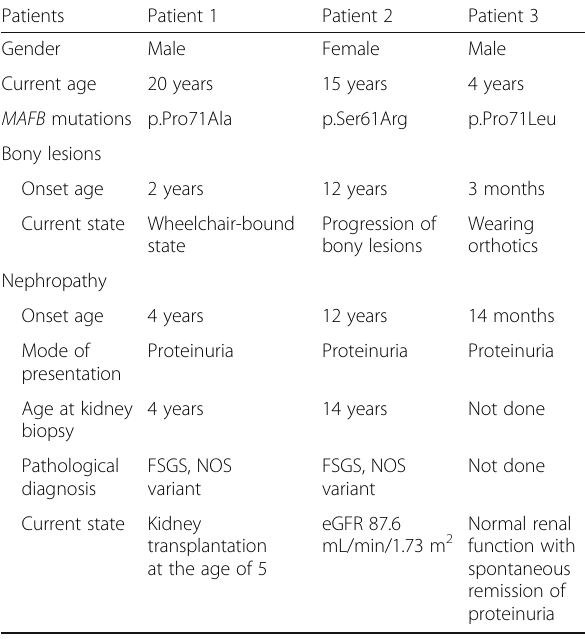
FSGS focal segmental glomerulosclerosis, NOS not-otherwise specified, eGFR estimated glomerular filtration rate calculated using the Schwartz